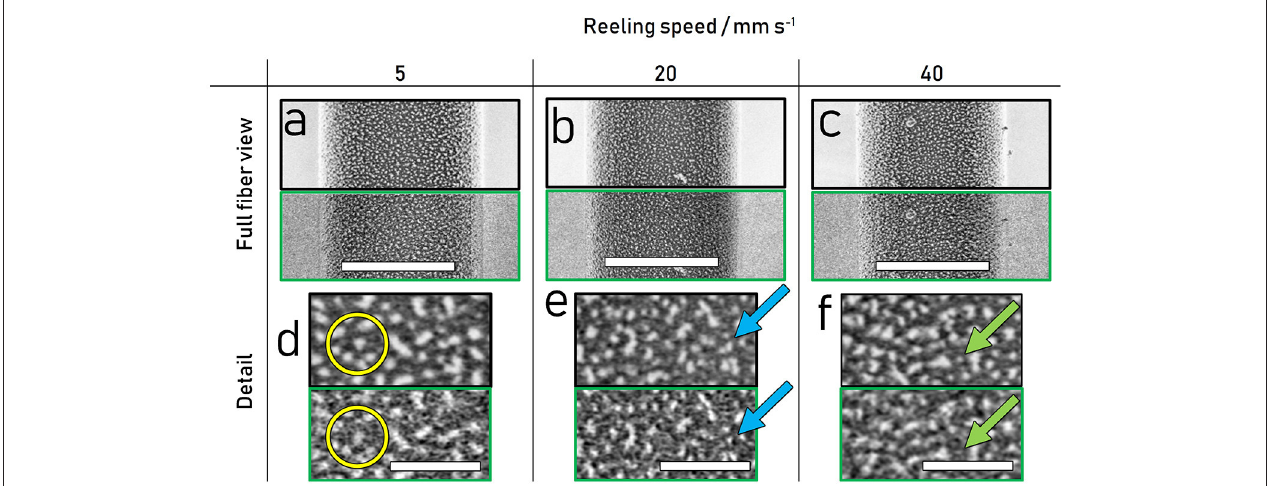
FIGURE 5 | Comparison of regular SE (top with black border) and contrast-optimized hyperspectral images (bottom with green border) of 10min plasma etched spider dragline silk reeled at 5, 20 and 40mm s − 1 . (a–c) View across fiber, scalebars measure 3 µ m (d–f) Detailed representation showing higher resolution and increased detail in the hyperspectral images, scalebars measure 500nm. All images acquired at 500eV primary beam energy.